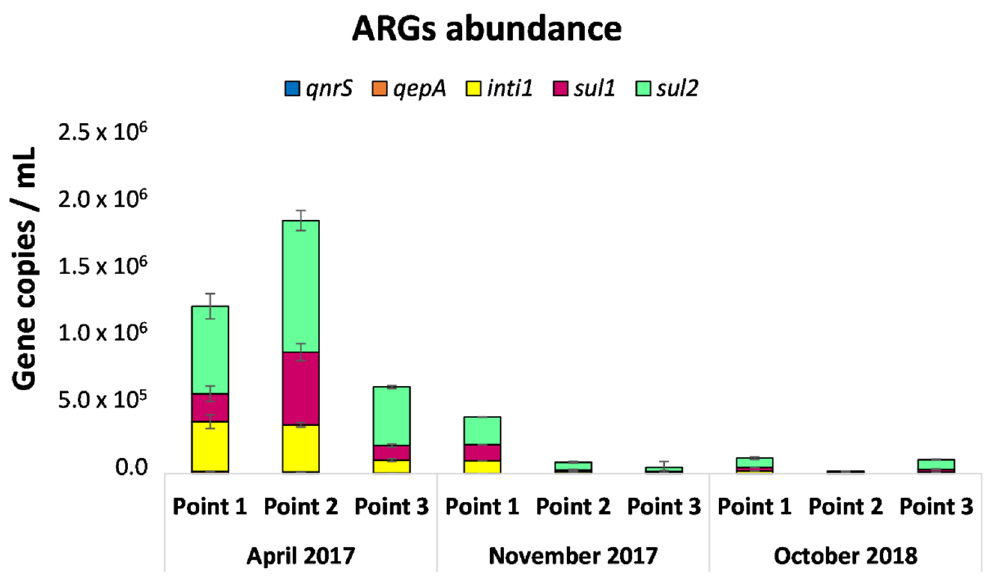
Figure 4. Gene abundance (gene copies/mL) of the five ARGs measured at the three sampling points (1, 2 and 3) during the three sampling times.